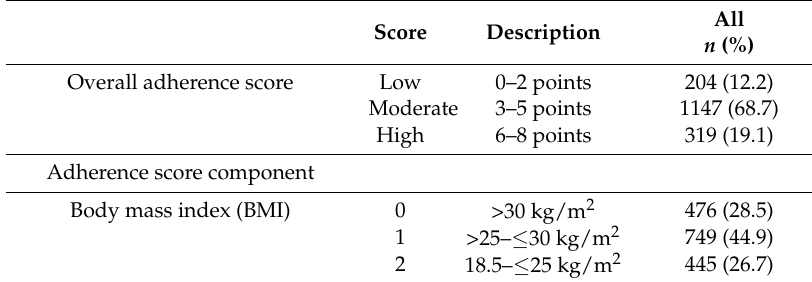
Table 1. Components of the guideline adherence score and distribution in the study